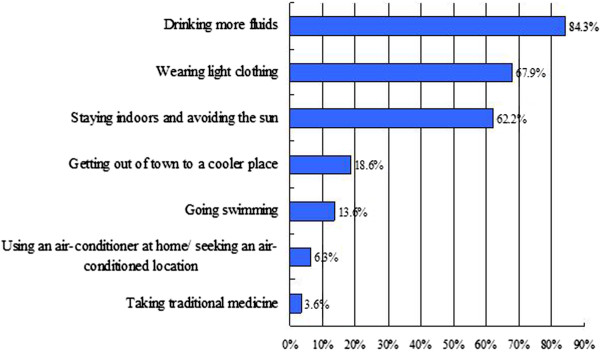
Options taken by respondents who reported they altered their behaviour in hot days.